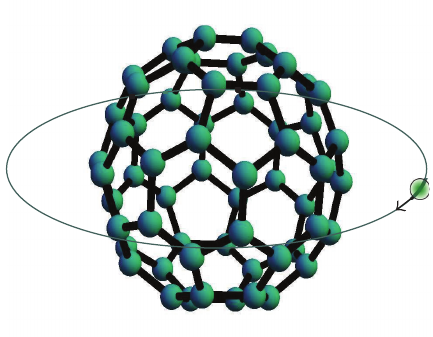
Figure 1: Schematic illustration of a charged particle captured by the image potential and orbiting around a buckyball. The radius of the orbit is determined by the dielectric constant within and surrounding the shell as well as the angular momentum quantum number of the captured particles. For semiconducting shells, the localization is strong and the radius of the stable orbit can be a few nanometers. The localization is weak for metallic